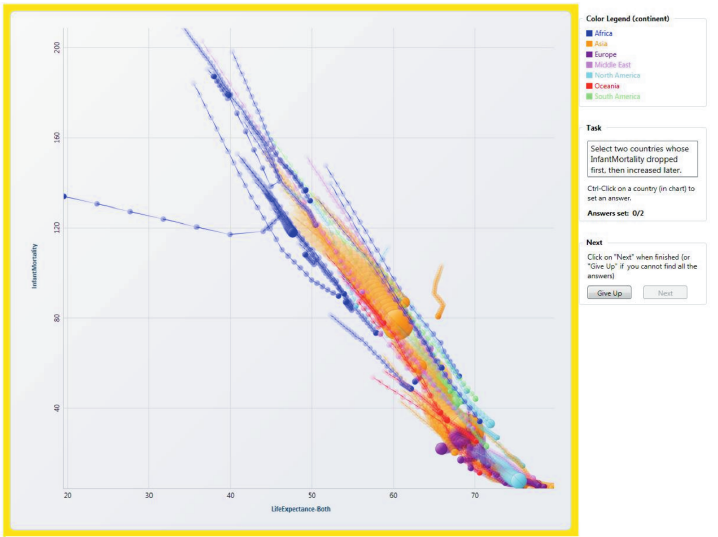
Figure 23. Robertson et al. show the trace lines of the graph animation. The traces visualization shows bubbles at all x and y locations throughout the time frame. This is a conversion of an animation into a static image [46]. Image courtesy of Robertson et al. [46].